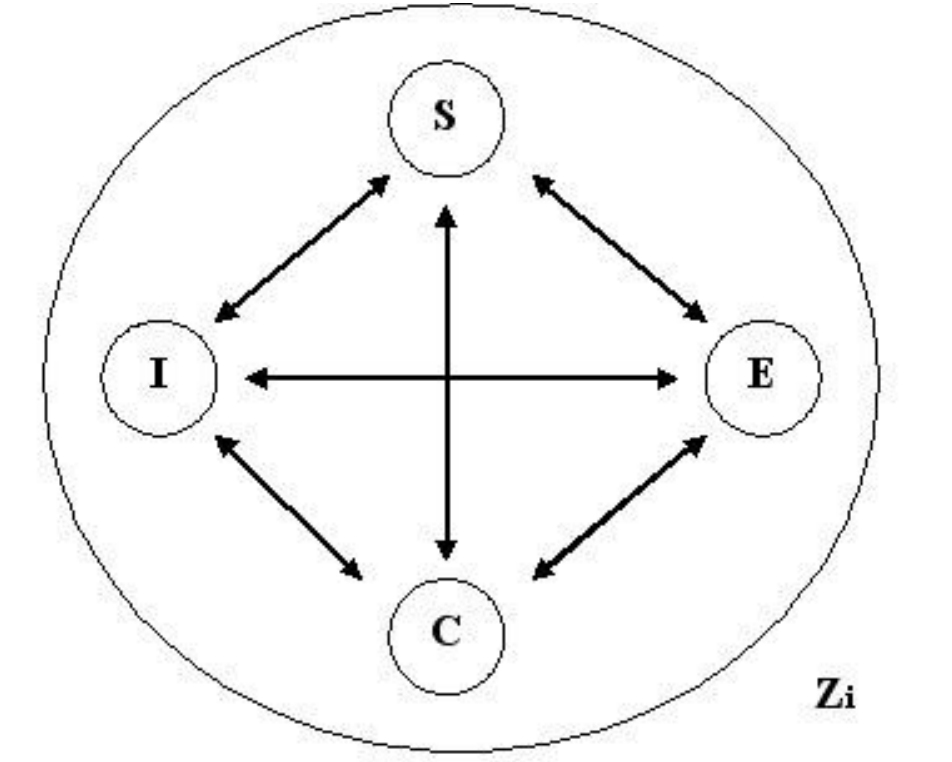
Fig. 2. The social-ecological system as represented by the SEIC model (Tàbara 2003). S = structure and ruling institutions, E = energy and resources, I = information and knowledge, C = social-environmental change, and Z = size of social-ecological system i i